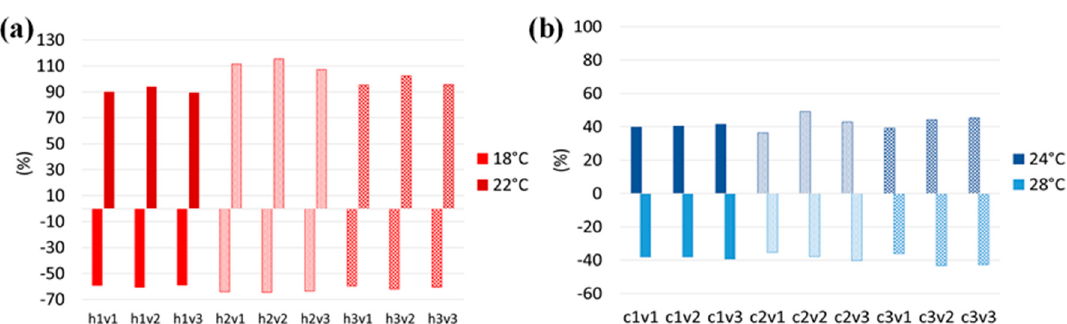
Figure 11. Relative differences of the ( a ) heating and ( b ) cooling energy needs caused by a variation of the setpoint temperature of ±2 °C in 2080.